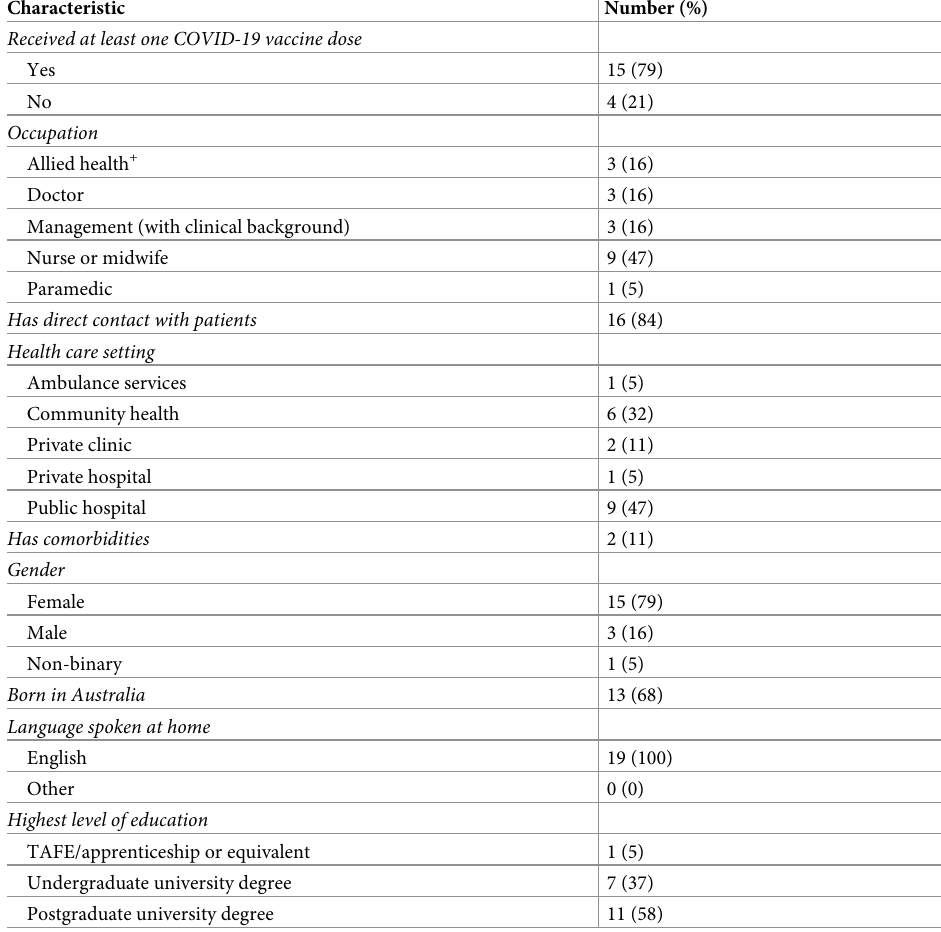
Table 1. Demographic information of 19 healthcare workers based in Western